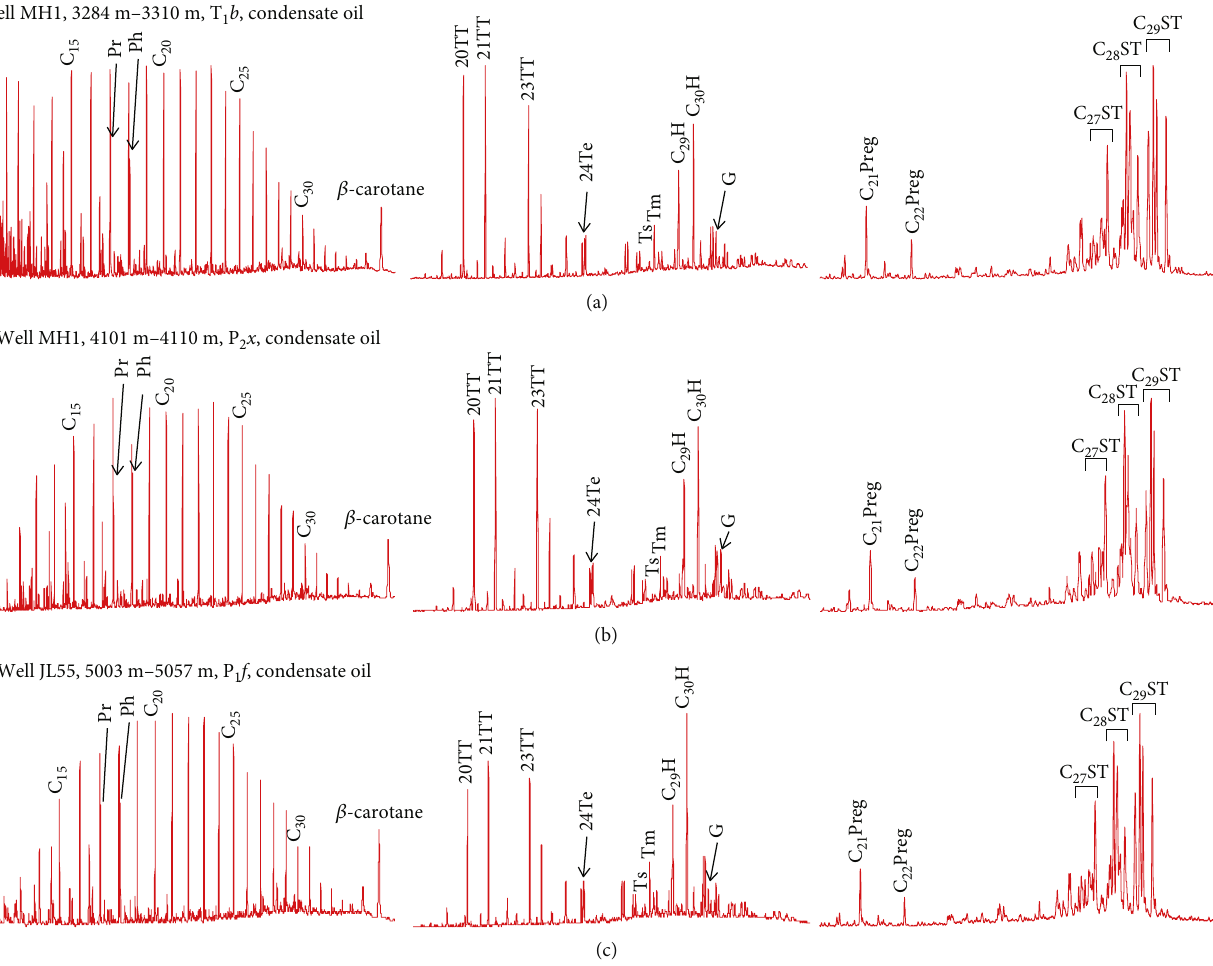
Figure 10: Oil-source correlation analysis of Wells MH1 and JL55 in the Mahu